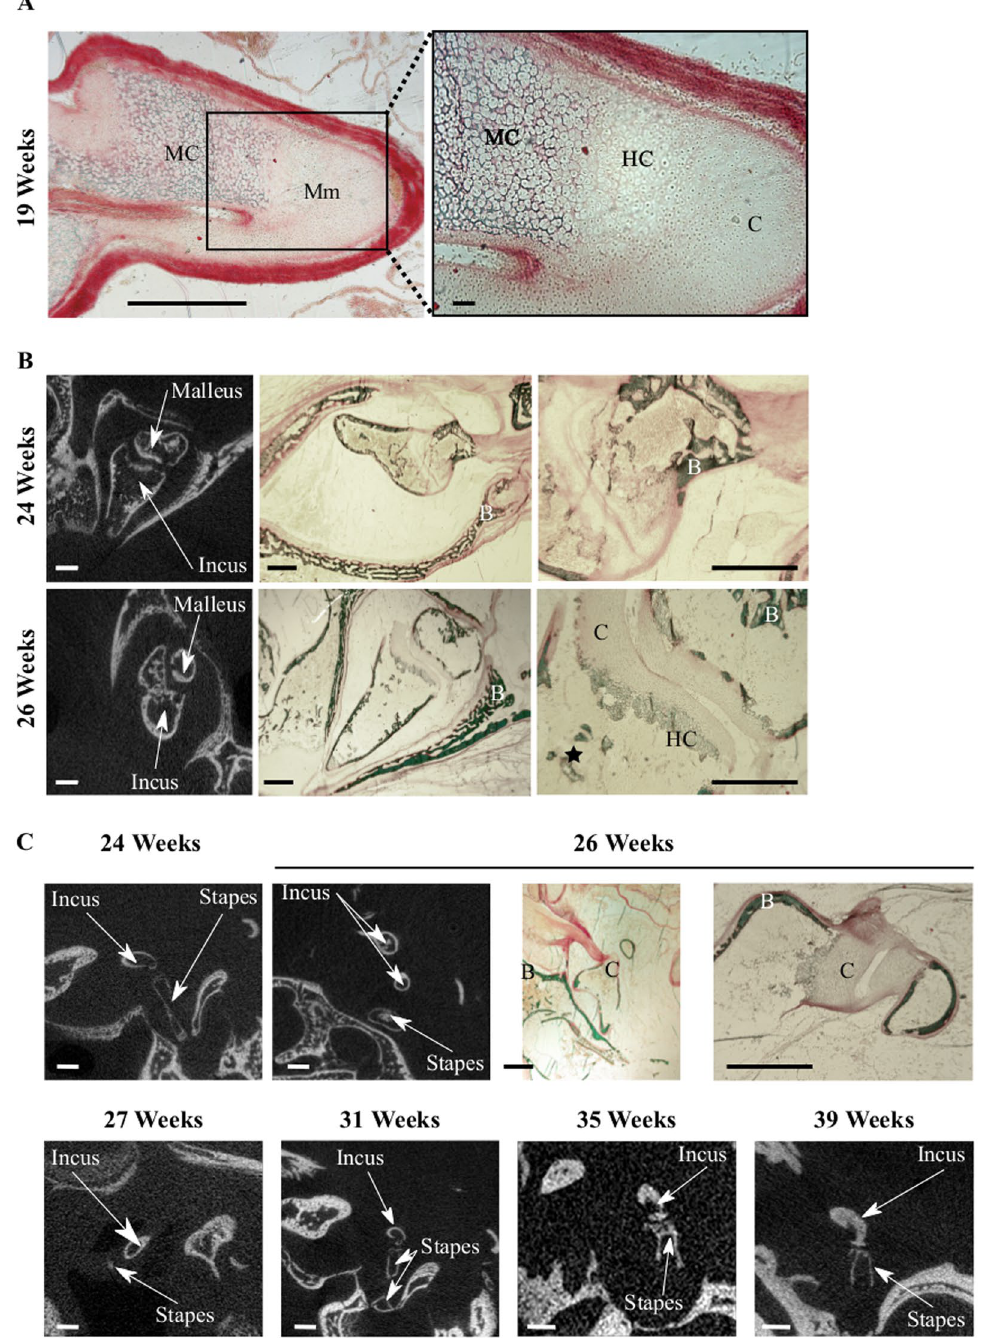
Figure 2. Inner ear development – Inter ossicle articulations. ( A ) Goldner stained sections of the Malleus at 19 weeks. Mm: Manubrium, B: Bone, C: Cartilage, HC: Hypertrophic Cartilage, MC: Mineralized Cartilage. 2D μ CT images and Goldner stained sections of the incudomallear ( B ) and incudostapedial ( C ) articulations between 24 and 39 weeks. Bars = 1.0 m, except inset in A: 100 μ